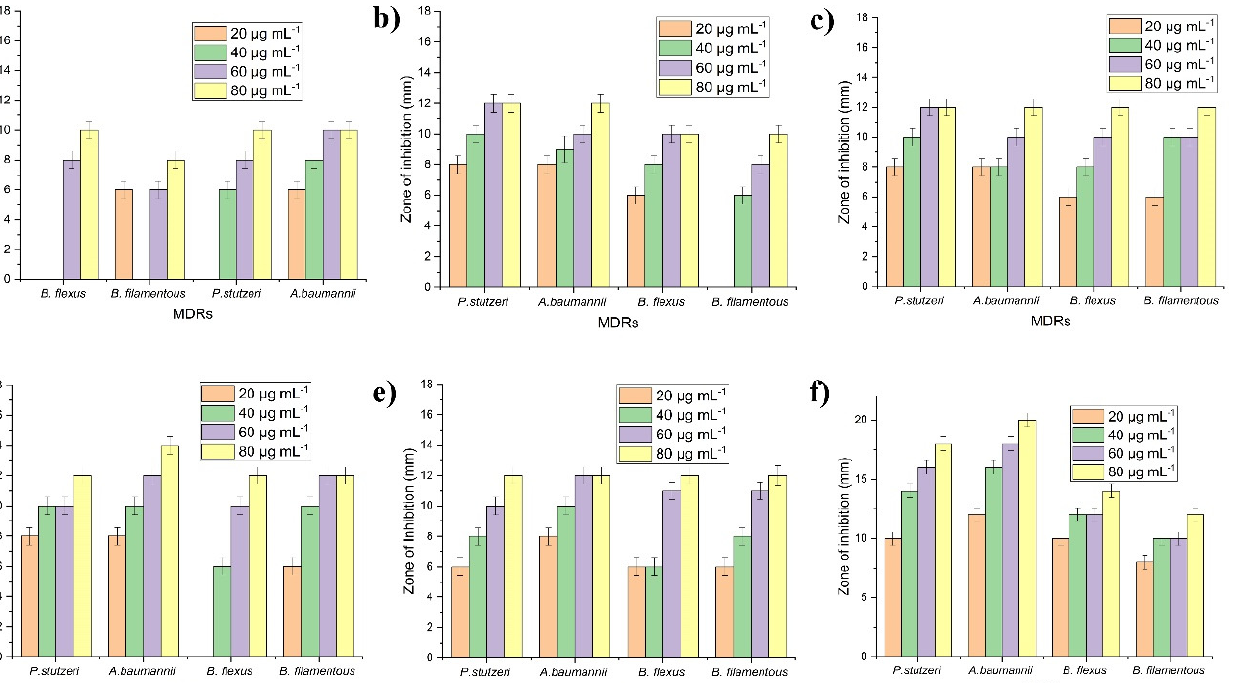
Table 1. ANOVA in vitro antibacterial susceptibility testing performed with as-synthesized NPs and NCs at different concentrations (20, 40, 60, and 80 μ g mL − 1 ).